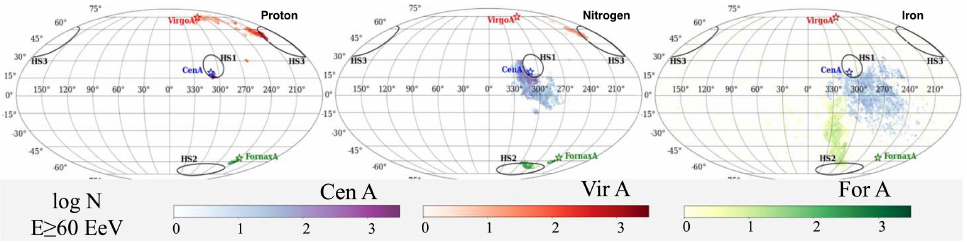
Figure 4. Sky maps (galactic coordinates) of the arrival direction of simulated UHECR events above 60 EeV for a strong and highly structured extragalactic magnetic field (Prim), along with the locations of three excess (HS: "hot spots") regions inferred from PA and TA maps (black solid circles). From left to right for proton, nitrogen and iron. The contributions from M87 (Virgo A), Cen A and Fornax A are shown in red, blue and green, respectively. Accordingly, light nuclei from Cen A may contribute to HS1, intermediate nuclei from Fornax A to HS2 and light to intermediate nuclei from M87 to HS3. From ref.